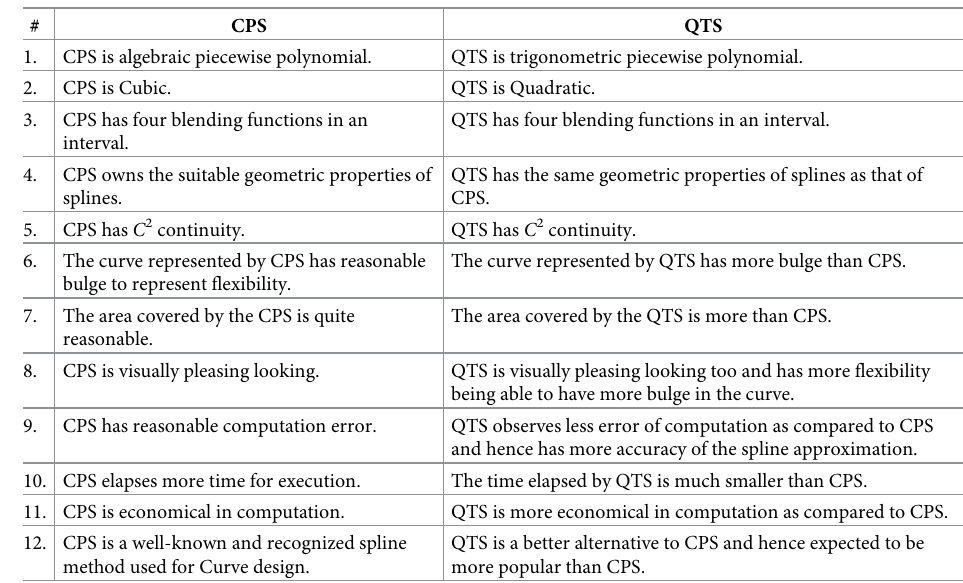
Table 4. Difference Table for QTS and